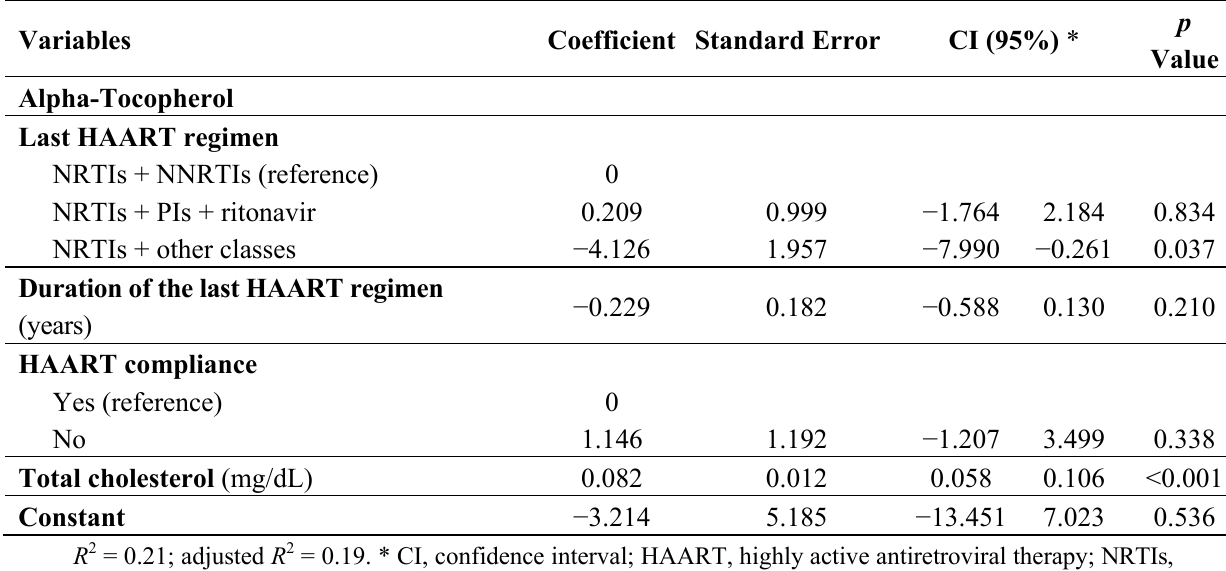
Table 2. Multiple linear regression model, considering alpha-tocopherol as the outcome variable ( n =